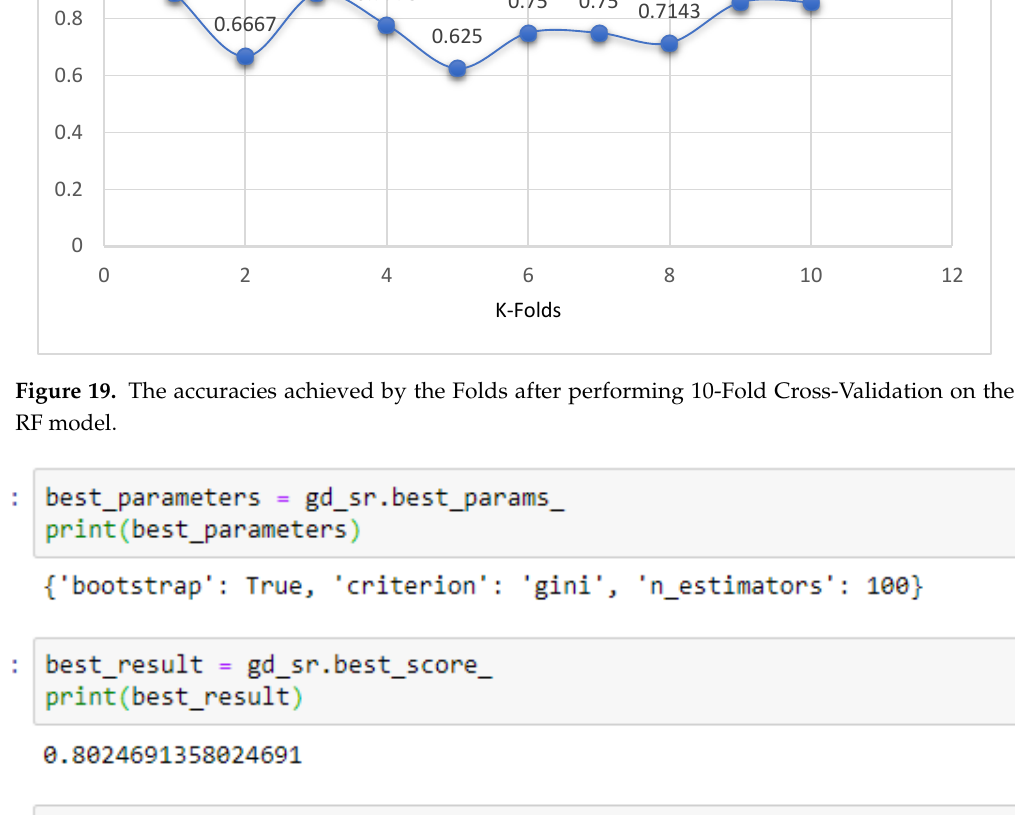
Figure 20. The best parameters with obtained after performing Grid Search with 10-Fold Cross-Validation based on the RF model.